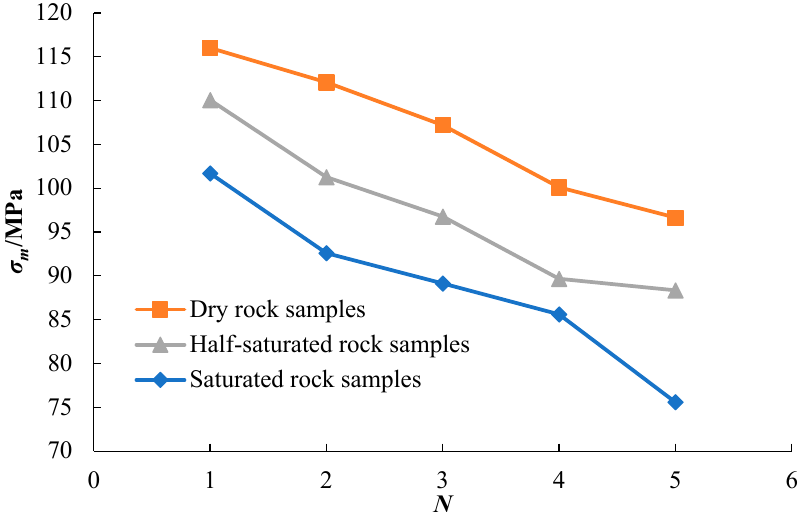
Figure 6. Peak stress variation trend ( σ m : peak stress; N : impact times).